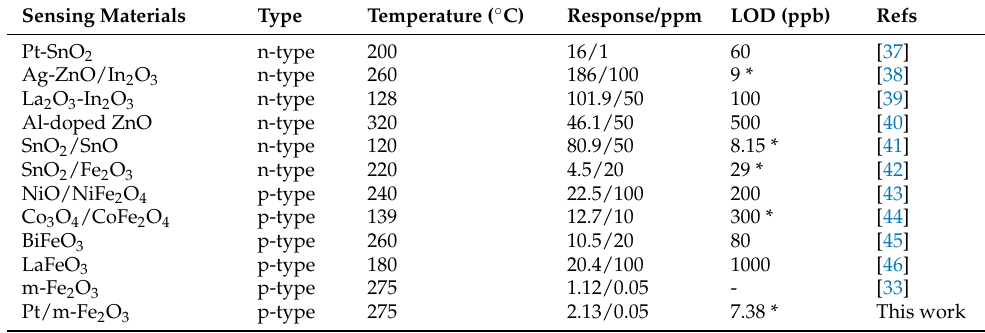
Table 1. Comparisons of HCHO gas-sensing characteristics based on sensing materials.